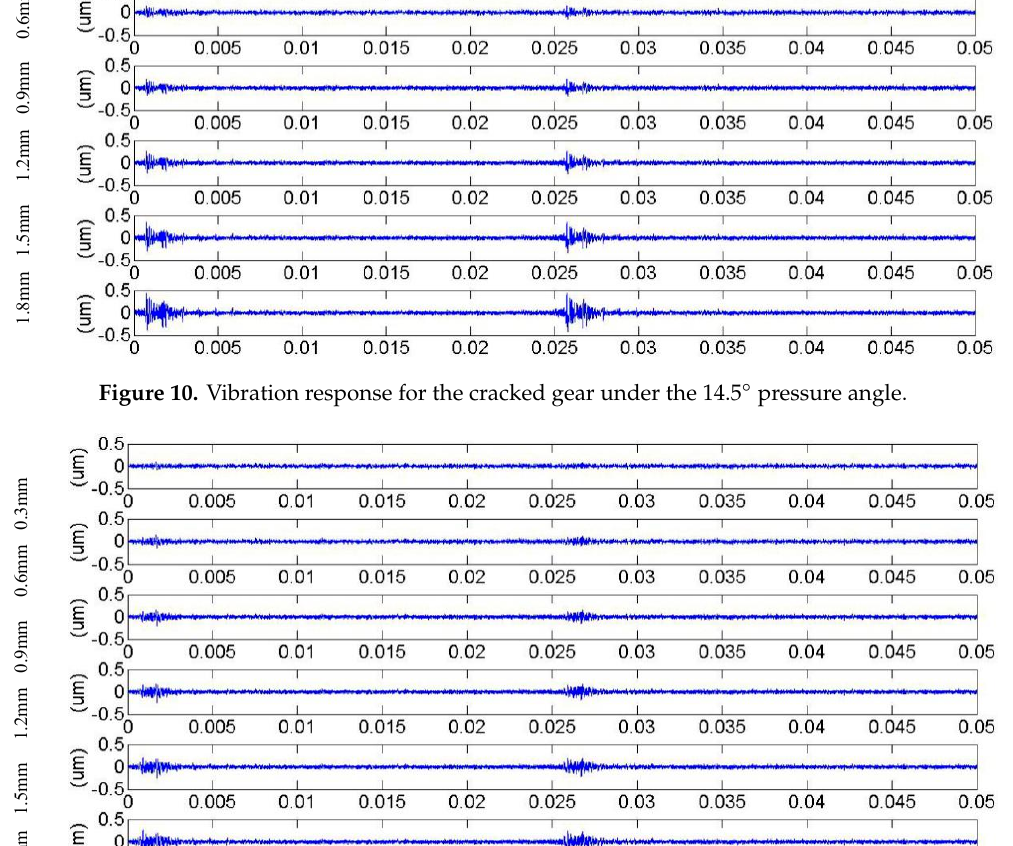
Figure 11. Vibration response for the cracked gear under the 20° pressure angle.